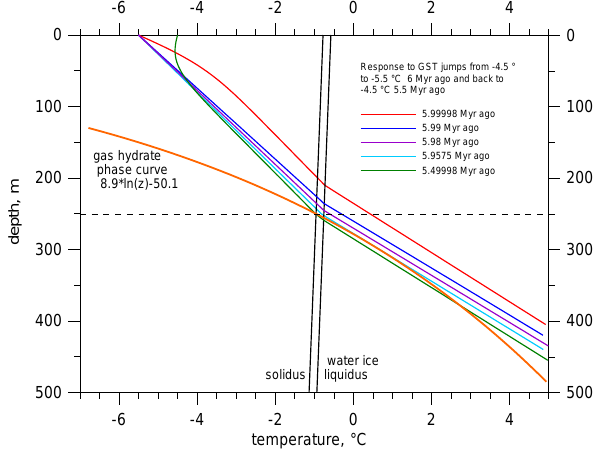
Fig. 6. Case 2 model transient temperature-depth profiles illustrating the response to cooling the GST from -4.5 °C to -5.5 °C at 6 Myr ago (and to all previous GST history since 14 Myr ago) followed by a warming back to -4.5 °C 5.5 Myr ago.